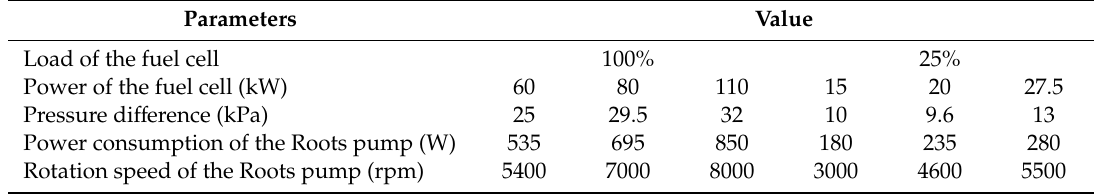
Table 3. Operating parameters of the Roots pump integrated into fuel cell systems. Parameters Value Load of the fuel cell 100% 25% Power of the fuel cell (kW) 60 Pressure di ff erence